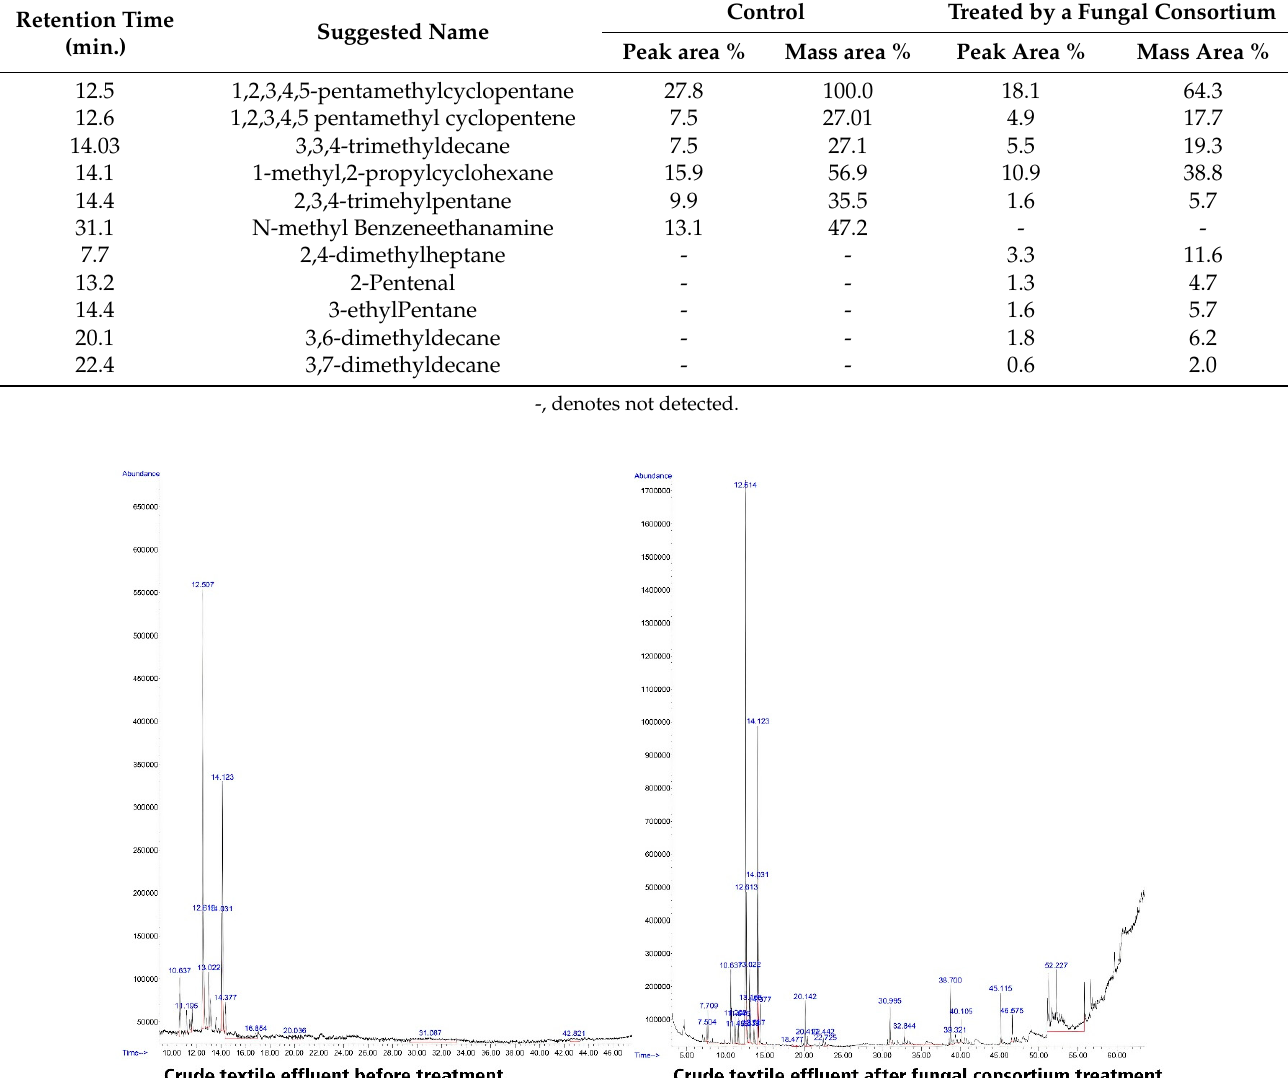
Table 3. Suggested compounds with peak and mass area resulted from GC –MS of textile effluent before and after fungal consortium treatment. Retention Time (min.)